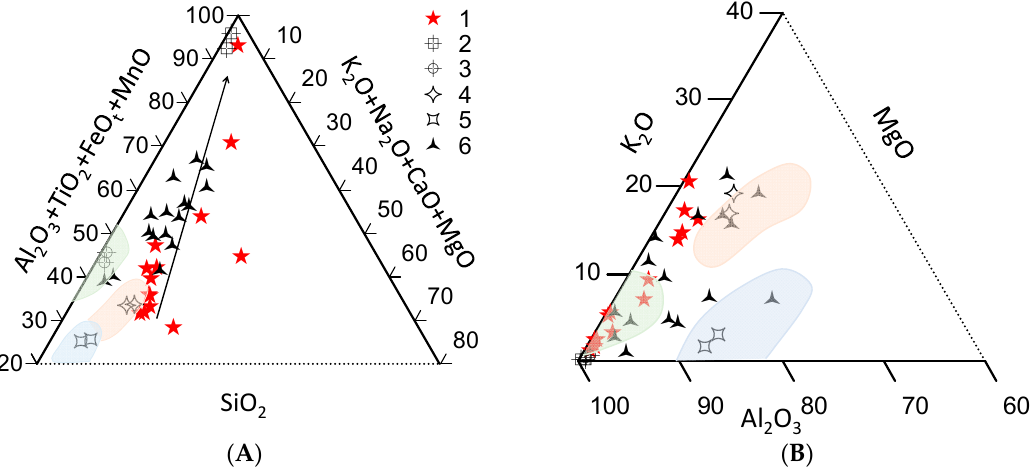
Figure 14. The Al 2 O 3 + TiO 2 + FeOt + MnO—K 2 O + Na 2 O + CaO + MgO—SiO 2 ( A ) and K 2 O—MgO—Al 2 O 3 ( B ) ternary diagrams with the data of Snezhnoe ruby-bearing rocks from this study–1; Precambrian pelitic sediments: bauxite ores–2, kaolinitic clays–3 and green field, illitic clays–4 and orange field, montmorillonite clays–5 and blue field (numbers 2–5 are the mean values of sediments after [47], the pelitic rock fields are after [48]); Al-enriched metamorphic rocks of Muzkol series–6 are after [49]. The rocks under numbers 2 and 3 overlap in the panel B.